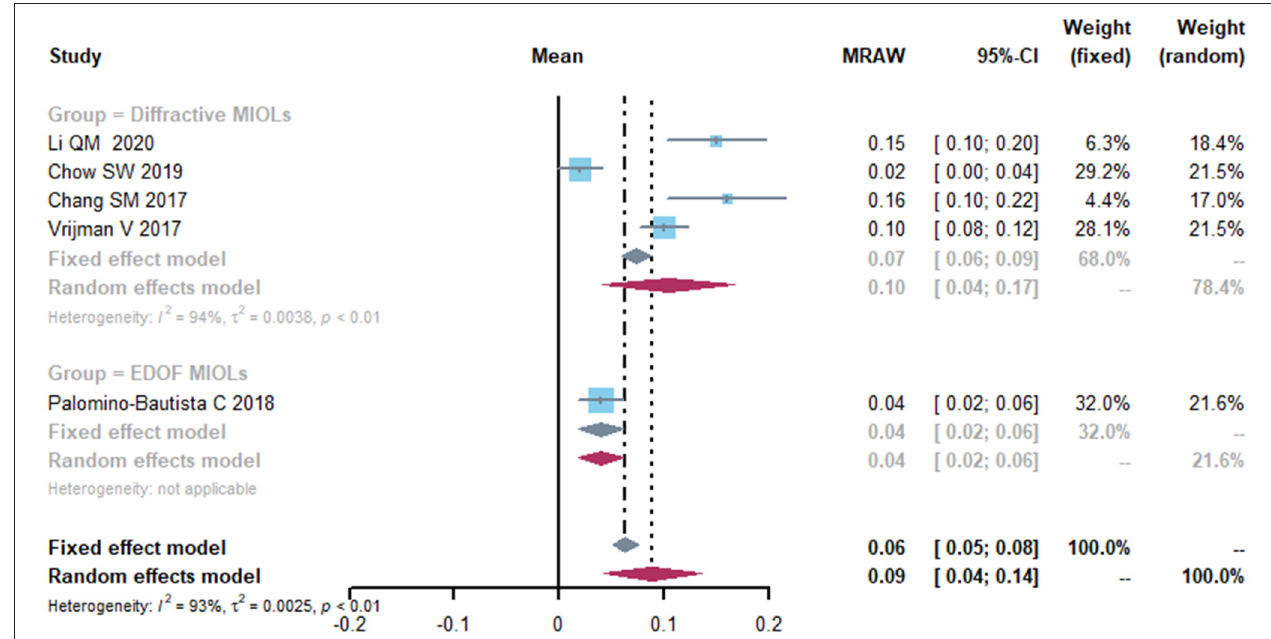
FIGURE 4 | Forest plot of uncorrected near visual acuity (UNVA) in logMAR. IOL, intraocular lense; MIOLs, multifocal intraocular lenses; EDOF, extended depth-of-focus; MRAW, the row mean from the study.